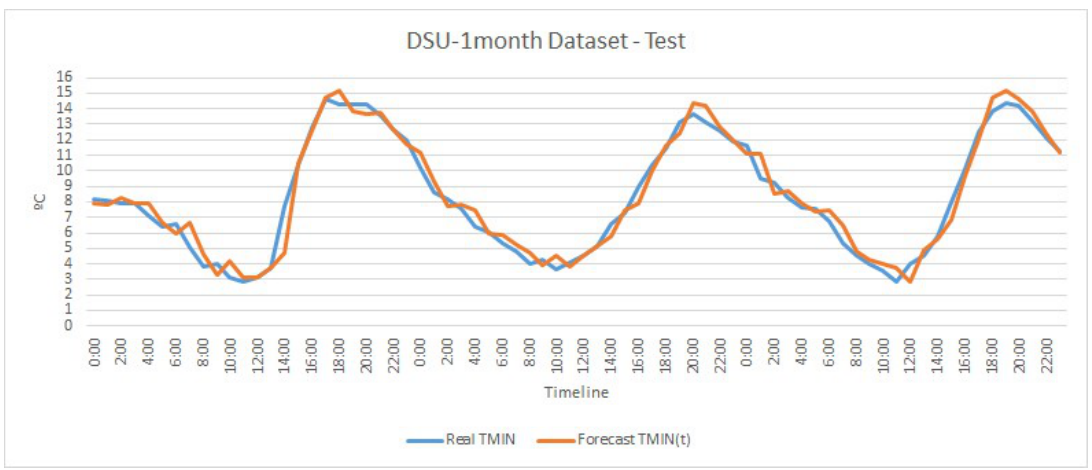
Figure 4. Graphical representation of the actual and predicted minimum temperature values in the test by the univariate LSTM model for the dataset DSU-1-month.